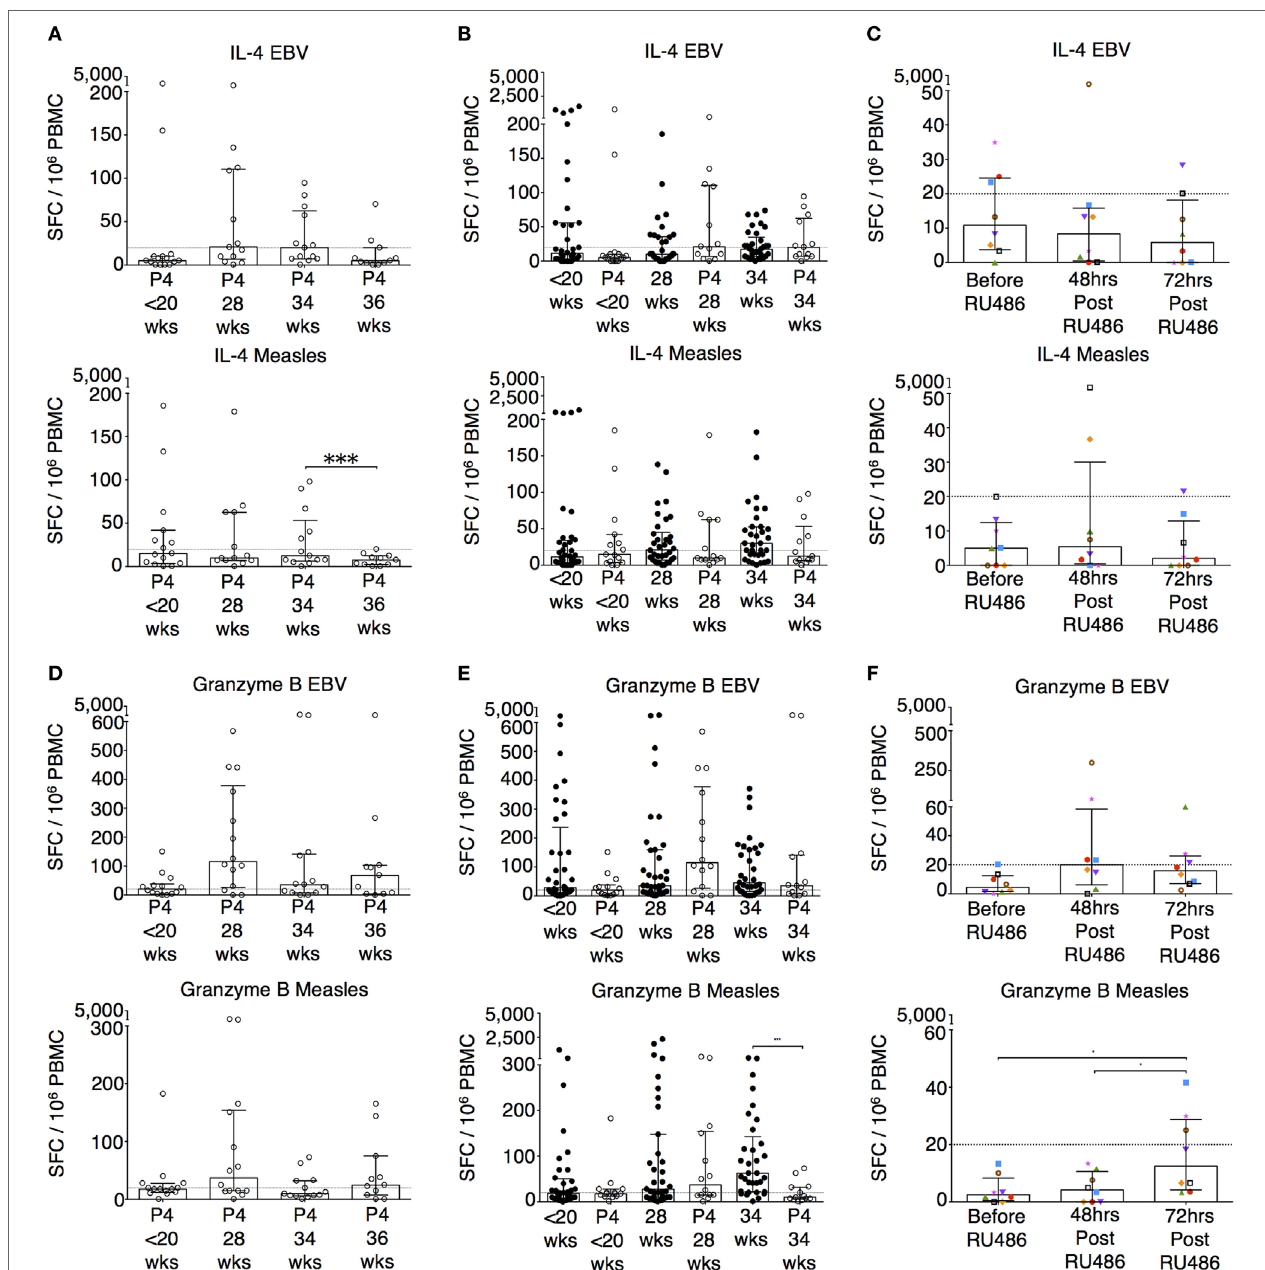
FigUre 6 | P4 and RU486 have little impact on IL-4 B ELISpot responses but P4 suppresses and RU486 enhances Granzyme B ELISpot responses. EBV and measles responses are shown. (a) Longitudinal changes in IL-4 responses with P4 treatment. (B) Comparison of IL-4 responses in P4 treated and controls, and (c) longitudinal analysis in RU486 treated. (D) Longitudinal changes in granzyme B responses with P4 treatment. (e) Comparison of granzyme B responses in P4 treated and controls, and (F) longitudinal analysis in RU486 treated. Gestation at sampling is indicated: in pregnant controls ( ⚫ ) at < 20 + 0 weeks ( N = 42 ), 28 weeks ( N = 35 ), 34 weeks ( N = 33 ); and P4 treated pregnancies ( ⚪ ) at < 20 + 0 weeks ( N = 15 ), 28 weeks ( N = 13 ), 34 weeks ( N = 13 ), 36 weeks ( N = 11 ). For RU486 treated ( N = 8 ) symbols represent individual patients. A dashed line represents < 20 spot forming cells/10 6 . Longitudinal data were analyzed with either one-way analysis of variance with Tukey’s post hoc correction or Freidman test with Dunn’s post hoc correction depending on the data distribution. P values are two tailed and significance is defined as *** P <